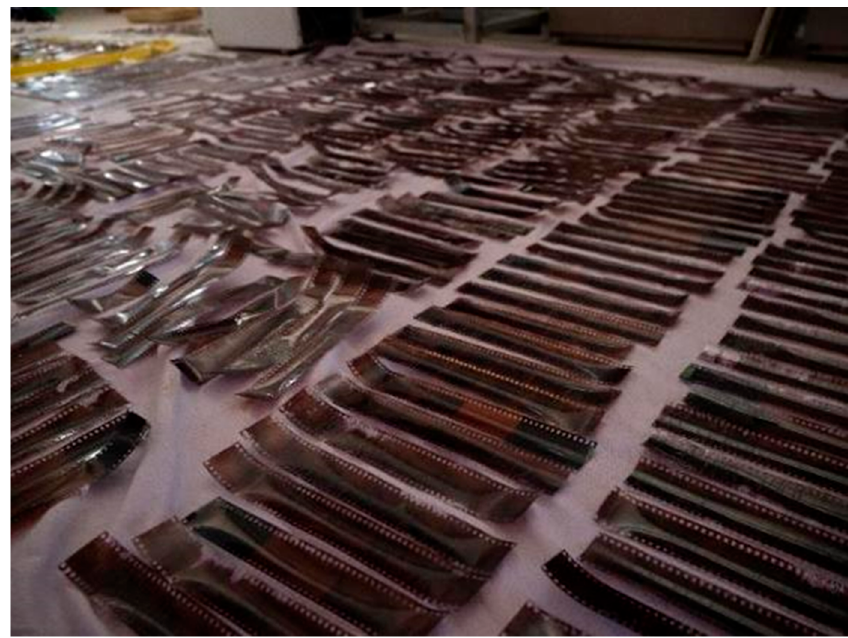
Figure 3. A view of the massive survey and recovering campaign of the Dainelli photographic ar-